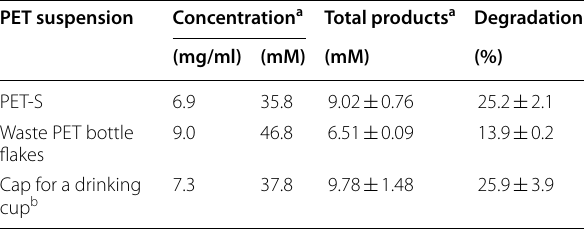
Table 3 Comparison of degradabilities of PET suspensions from different PET